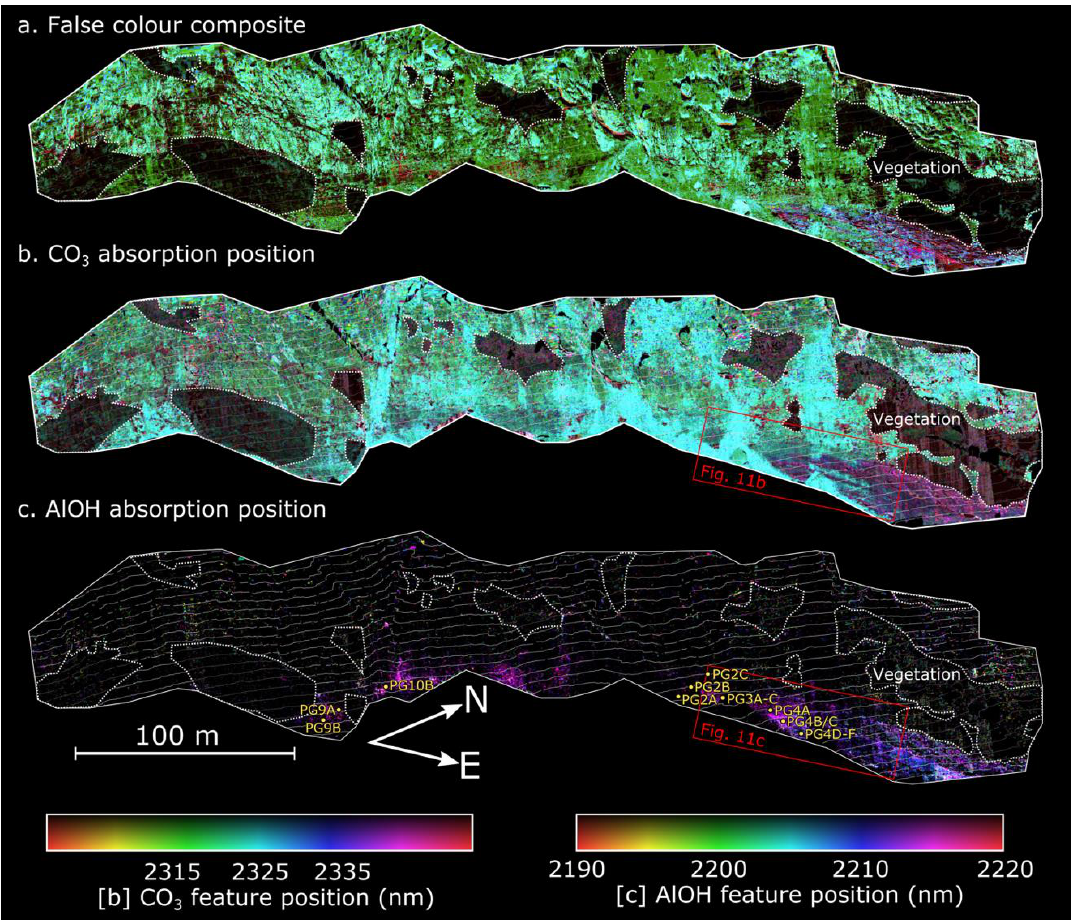
Figure 11. False-colour visualisation of the merged and radiometrically corrected hypercloud ( a ) and minimum wavelength maps showing the distribution of calcitic (blue) and dolomitic (green) carbonates ( b ) and clay/mica minerals (purple; c ). The location of the validation spectra shown in Figure 9 are overlain on ( c ) in yellow for reference.